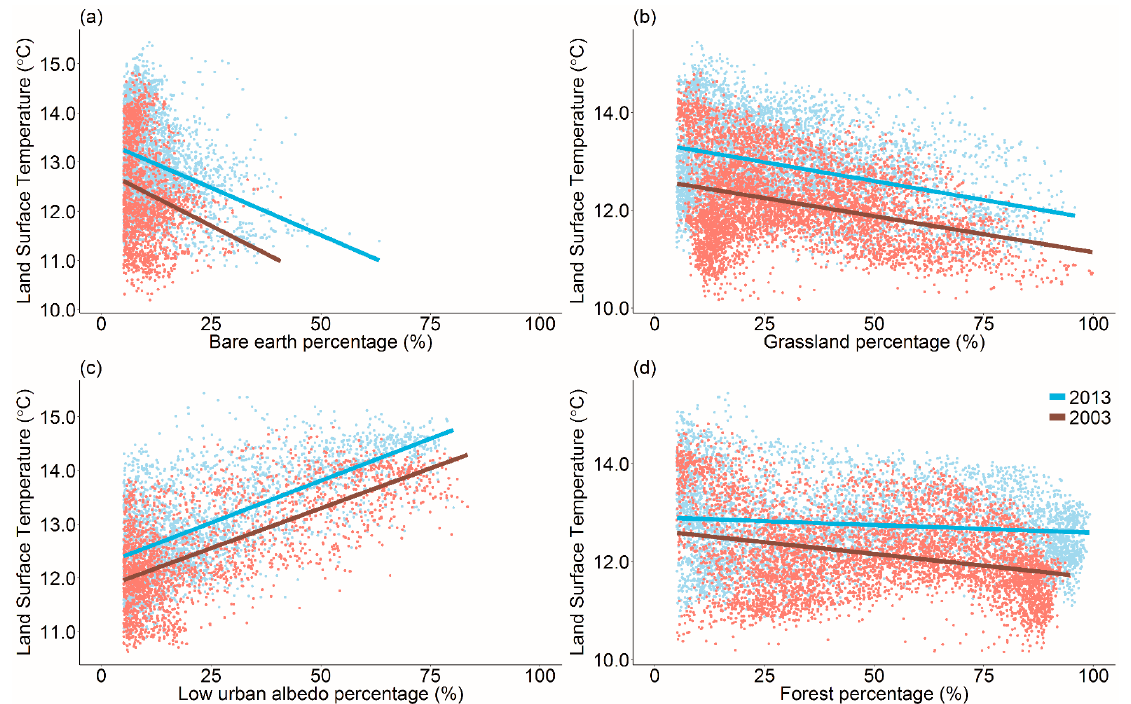
Figure 5. The 2003 and 2013 percentage land cover within a MODIS pixel and average annual nighttime LST for 2003 and 2013 for: ( a ) Bare earth ( b ) Grassland ( c ) Low urban albedo and ( d ) Forest, with points (lighter colours) representing individual values of each year. All linear trends are statistically significant at p < 0.05.